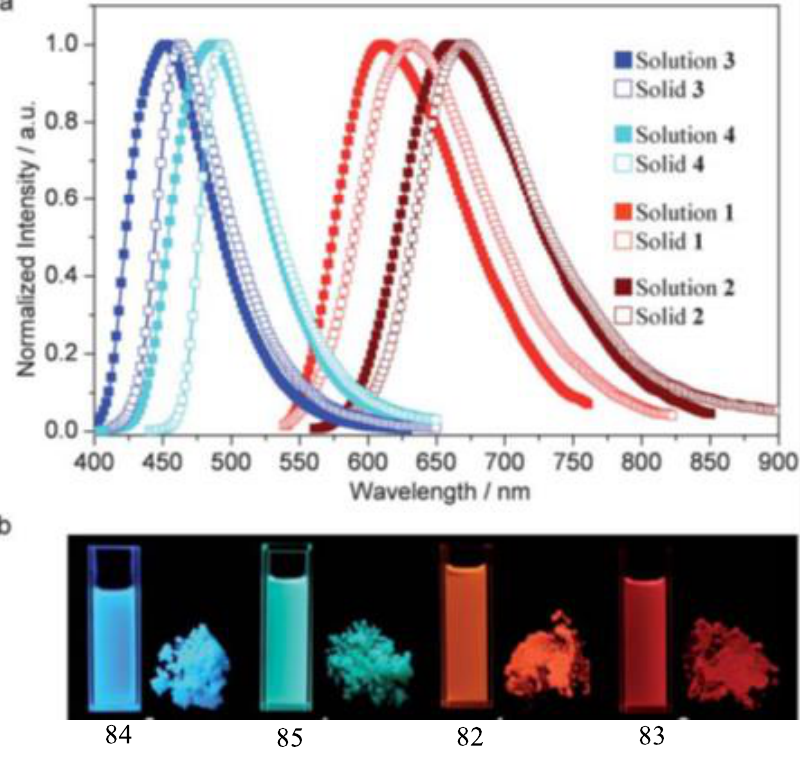
Figure 20. Emission spectra ( a ) and photographs under UV light (365 nm) ( b ) of 82 – 85 in CH 2 Cl 2 and the solid state.